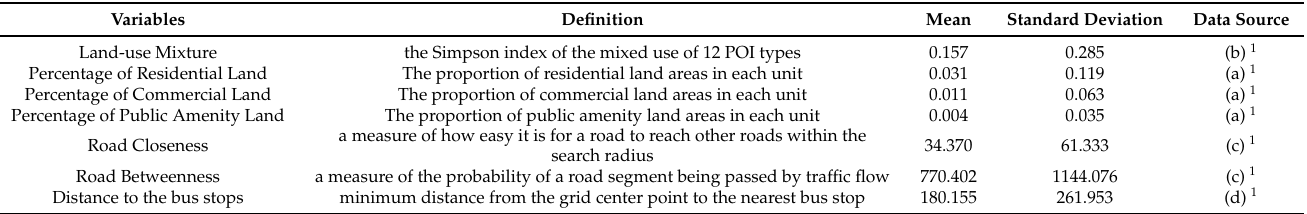
Table A2. The built environment elements selected for this study suggest that the determinants of urban